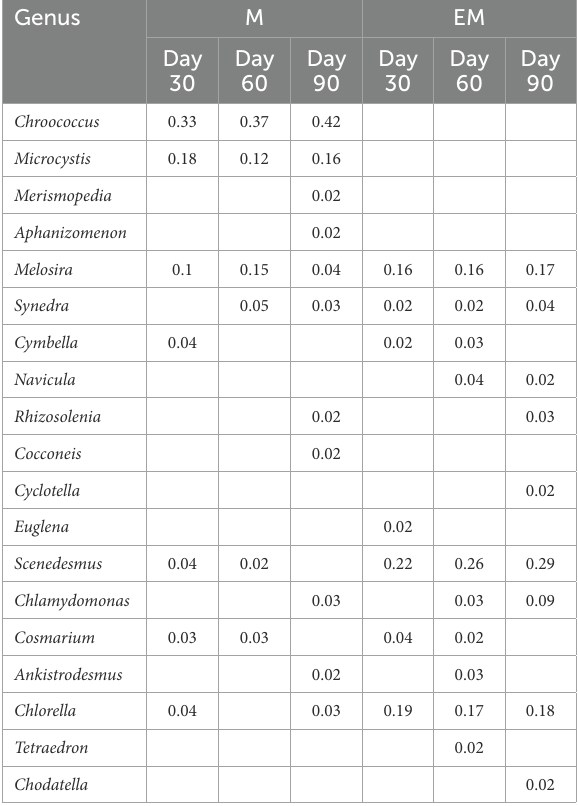
TABLE 3 Dominant genera and their dominance values of phytoplankton in M and EM groups.